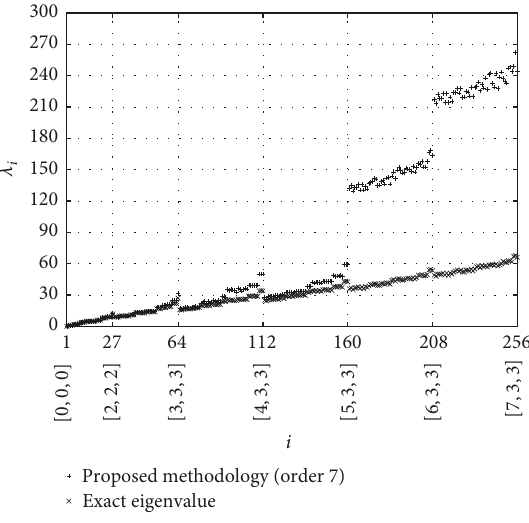
Figure 9: Cuboid eigenvalues (5th order, 𝑁 = 2 ).